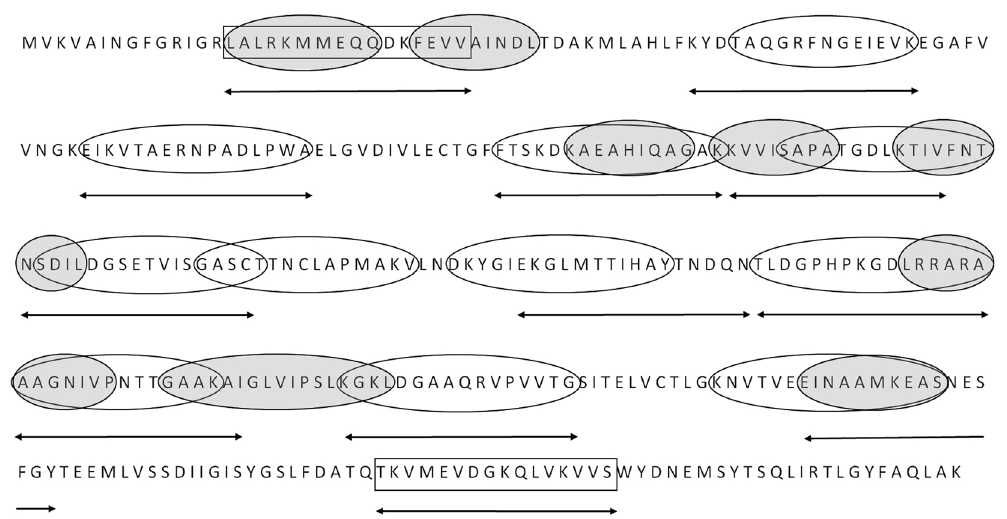
Figure 3. The design of peptides selected for mapping. Figure shows C. difficile GAPDH sequence and peptide sequences that were considered for mapping - identified by software as probable epitopes. Empty ovals – B-cell epitopes; shaded ovals – T-cell epitopes; rectangles – sequences in exposed loops. Sequences indicated by arrows are the one selected for chemical